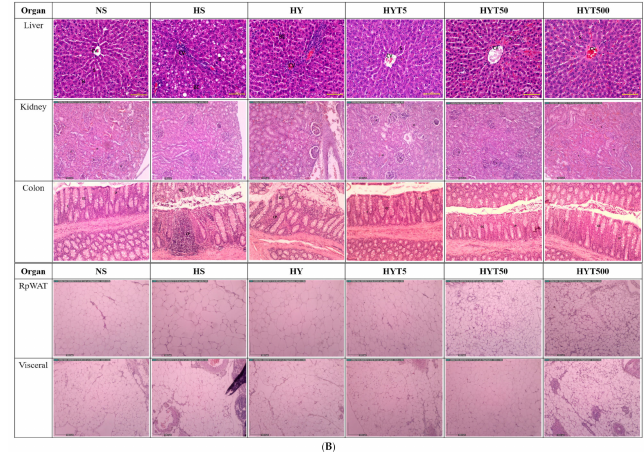
Figure 3. ( A ) The histopathological changes in liver, kidney, colon, RpWAT, and visceral fat tissue of male offspring on PND 21. HS shows abnormal strands of hepatocytes (H), sinusoids (S), and central veins (CVs). Cell ballooning, steatosis, and >30% of lobular inflammation were seen. The liver histology in the HY group shows abnormal hepatocytes, sinusoids, and CVs with hepatocyte ballooning with lipid droplets. There is no presence of steatosis or lobular inflammation in the HY group. The liver histology for male offspring of the NS, HYT5, HYT50, and HYT500 groups shows a completely normal architecture. The kidneys of male offspring of the HS and HY groups show slight tubular dilation, the presence of abnormal lesions, and slight abnormalities of the renal corpuscle, while the liver histology for male offspring of the NS, HYT5, HYT50, and HYT500 groups shows a completely normal architecture. The colons in male offspring of the HS and HY groups show a detachment of epithelial cells, reduced mucosal content in the colonic wall, severe infiltration in the lamina propria, presence of inflammation, and fat deposition in the muscle layer. The colon structure of the male offspring in the HYT5, HYT50, and HYT500 groups shows a completely normal architecture. There is severe fat hypertrophy in male offspring of the HS group in retroperitoneal white adipose tissue (RpWAT) and visceral fat tissue. ( B ) The histopathological changes in liver, kidney, colon, RpWAT, and visceral fat tissue of female offspring on PND 21. HS shows abnormal strands of hepatocytes (H), sinusoids (S), and central veins (CVs). Cell ballooning, steatosis, and >30% of lobular inflammation were seen. The liver histology in the HY group shows abnormal hepatocytes, S, and CVs with hepatocyte ballooning with lipid droplets. There is no presence of steatosis or lobular inflammation in the HY group. The liver histology for female offspring of the NS, HYT5, HYT50, and HYT500 groups shows a completely normal architecture. The kidneys of female offspring in the HS and HY groups show slight tubular dilation, the presence of abnormal lesions, and slight abnormalities of the renal corpuscle. The liver histology for female offspring in the NS, HYT5, HYT50, and HYT500 groups shows a completely normal architecture. The colons in female offspring in the HS and HY groups show a detachment of epithelial cells, reduced mucosal content in the colonic wall, severe infiltration in the lamina propria, presence of inflammation, and fat deposition in the muscle layer. The colon structure of the female offspring in the HYT5, HYT50, and HYT500 groups shows a completely normal architecture. Severe fat hypertrophy in female offspring in the HS group in retroperitoneal white adipose tissue (RpWAT) and visceral fat tissue is